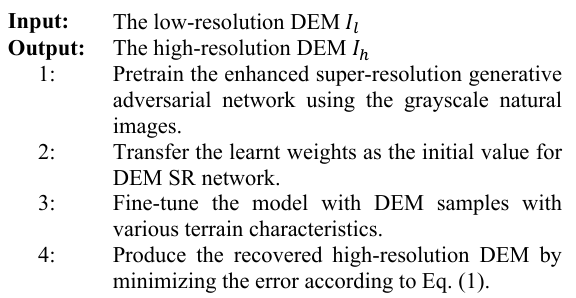
Algorithm 1 ESRGAN-based DEM SR